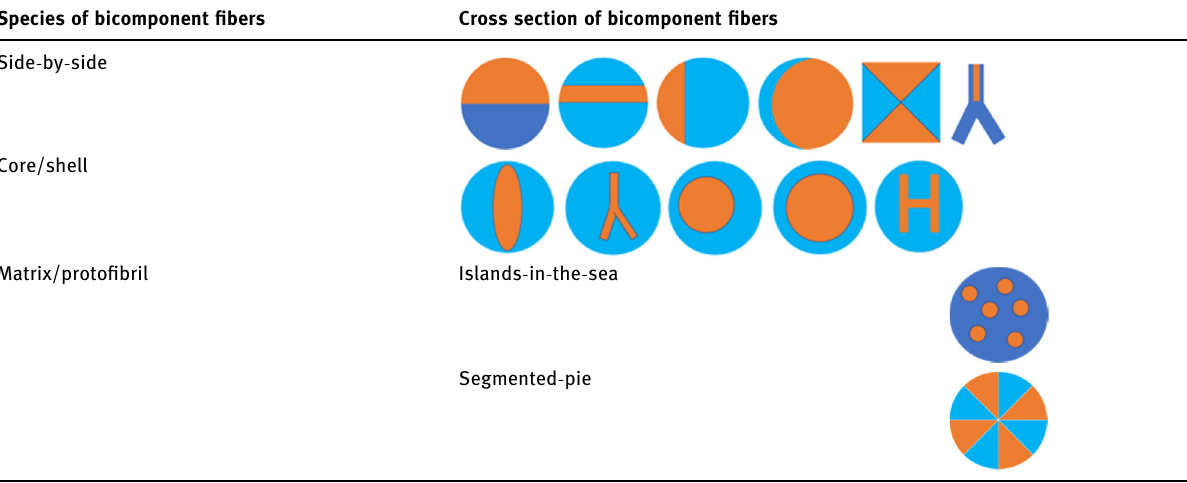
Table 1: Schematic diagram of the bicomponent fi ber Species of bicomponent fi bers Cross section of bicomponent fi bers Side - by -